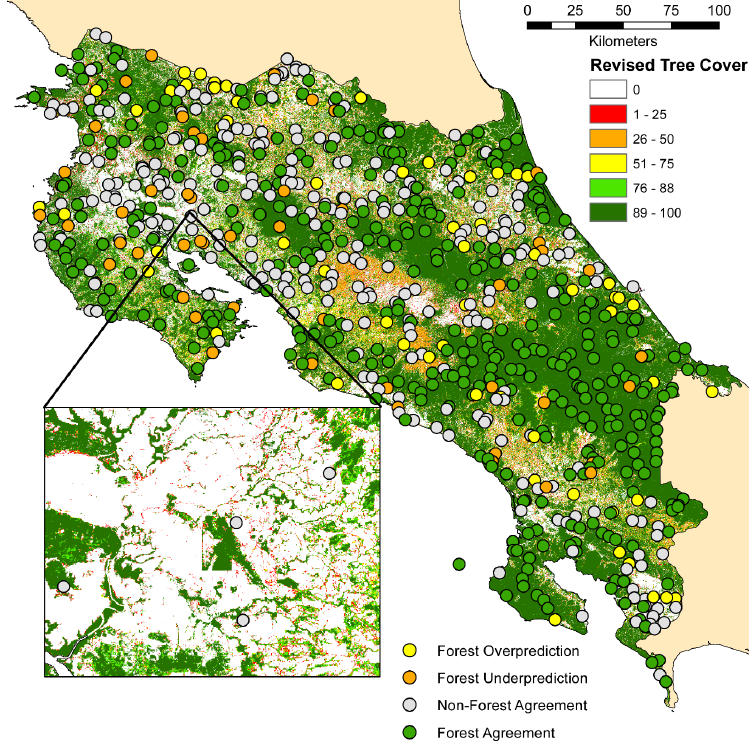
Figure 10. Corrected GFC tree cover map (2015), showing the spatial distribution of forest cover errors when compared to reference data (n = 1154). The point colors indicate the type of confusion matrix errors.